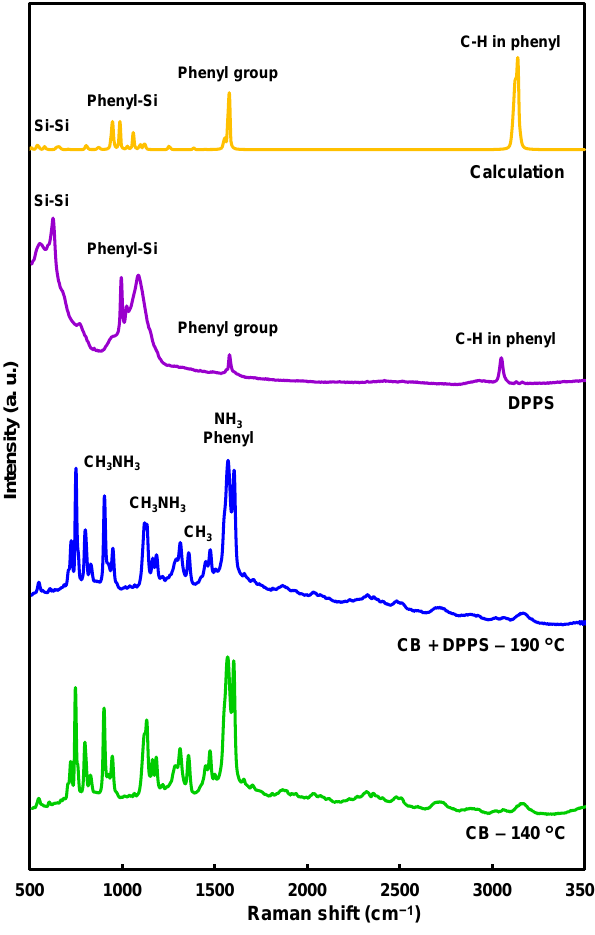
Figure 6. Raman spectra of DPPS and devices.